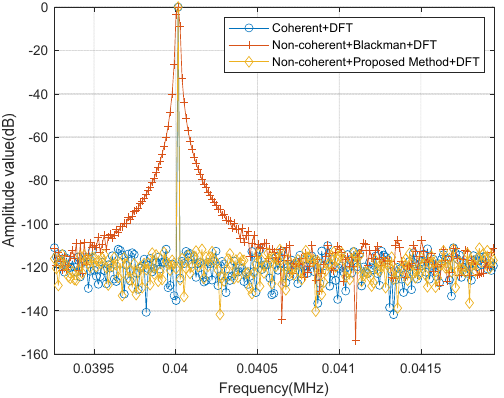
Figure 9. Spectrum comparison of different methods under coherent and incoherent sampling.